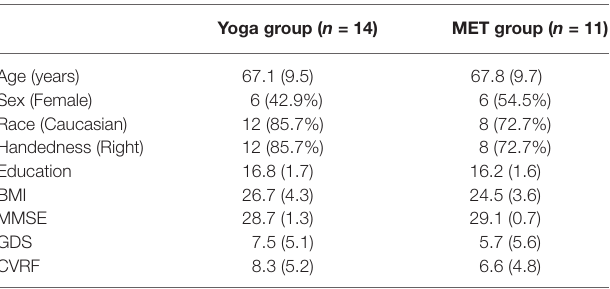
TABLE 1 | Demographic and clinic measures for yoga and memory enhancement training (MET)